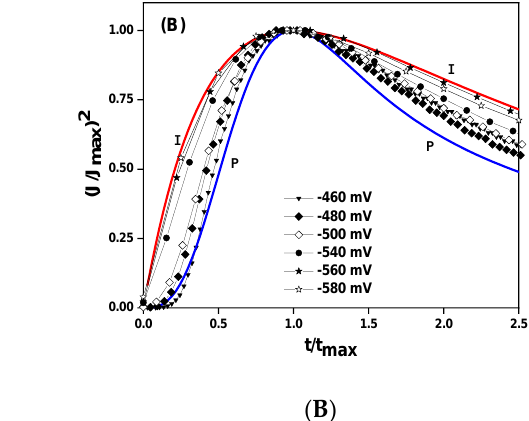
Figure 4. Potentiostatic current-time transients for the electrodeposition of Sn-rGO ( A ) from ILEG + 0.05 M SnCl 2 + 20 mg L − 1 GO at 25°C on GC electrode, at different potentials: (a) − 460 mV, (b) − 480 mV, (c) − 500 mV, (d) − 520 mV, (e) − 540 mV, (f) − 560 mV, (g) − 580 mV. The inset shows the dependence of i vs. t − 1/2 and linear fitting at − 580 mV. ( B ) Non-dimensional plots for the transients from ( A ): instantaneous (I, red line), progressive (P, blue line) and experimental data (black lines).